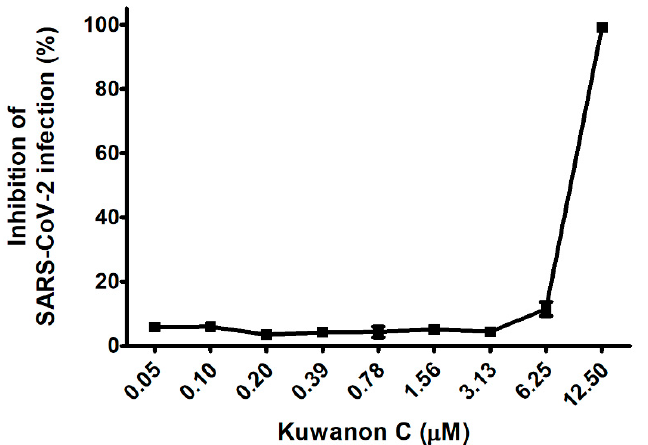
Figure Figure 5. KC suppresses the infection of a clinical isolate of SARS-CoV-2 alpha strain ( β CoV/Ko- rea/KCDC03/2020) in Vero cells. Vero cells were cultured on 384-well plates (1.2 × 10 4 cells/well) for 24 h. Then, Vero cells were infected with SARS-CoV-2 (MOI 0.0125) immediately after being treated with serially diluted KC and incubated at 37 °C for 24 h. The cells were then stained using anti-